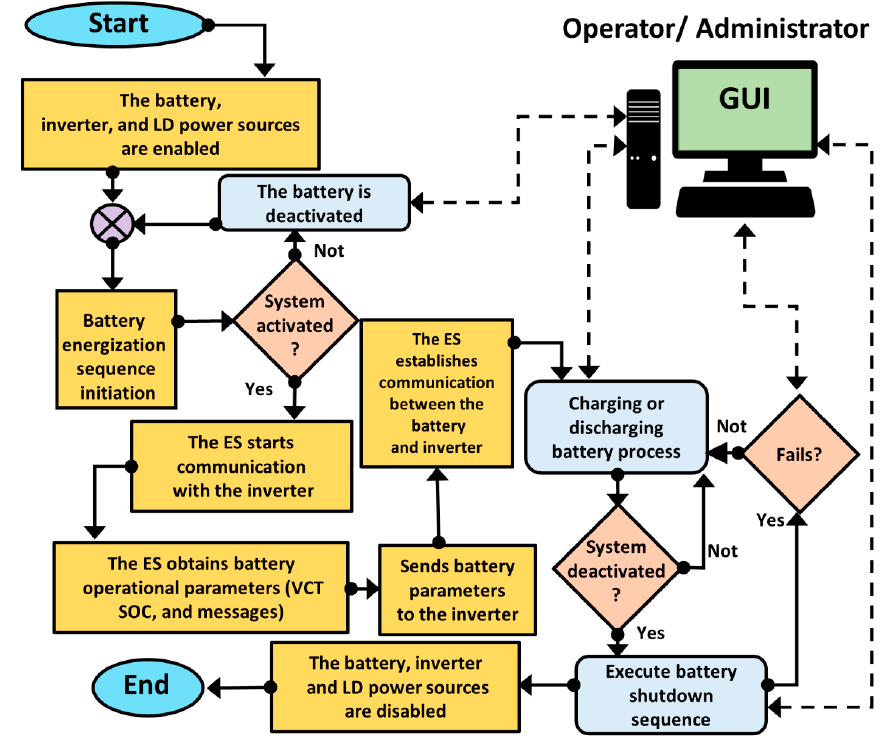
Figure 4. Flowchart describing the second-life ESS work sequence.